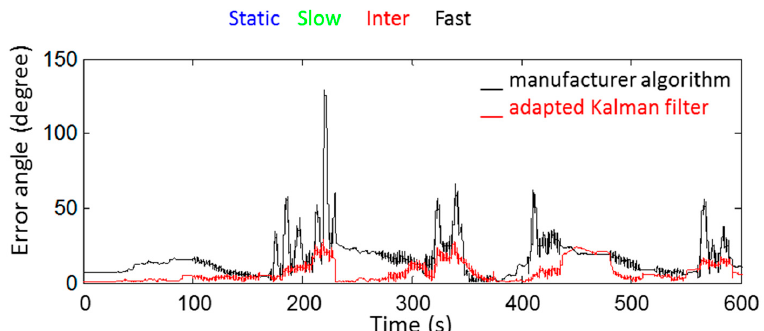
Figure 6. Orientation errors computed during the same 10 min movement for orientations obtained with adapted Kalman parameters and with the manufacturer algorithm. The orientation obtained with the optoelectronic system served as reference. The color bar at the top of the figure represents the intensity level recorded during the movement.